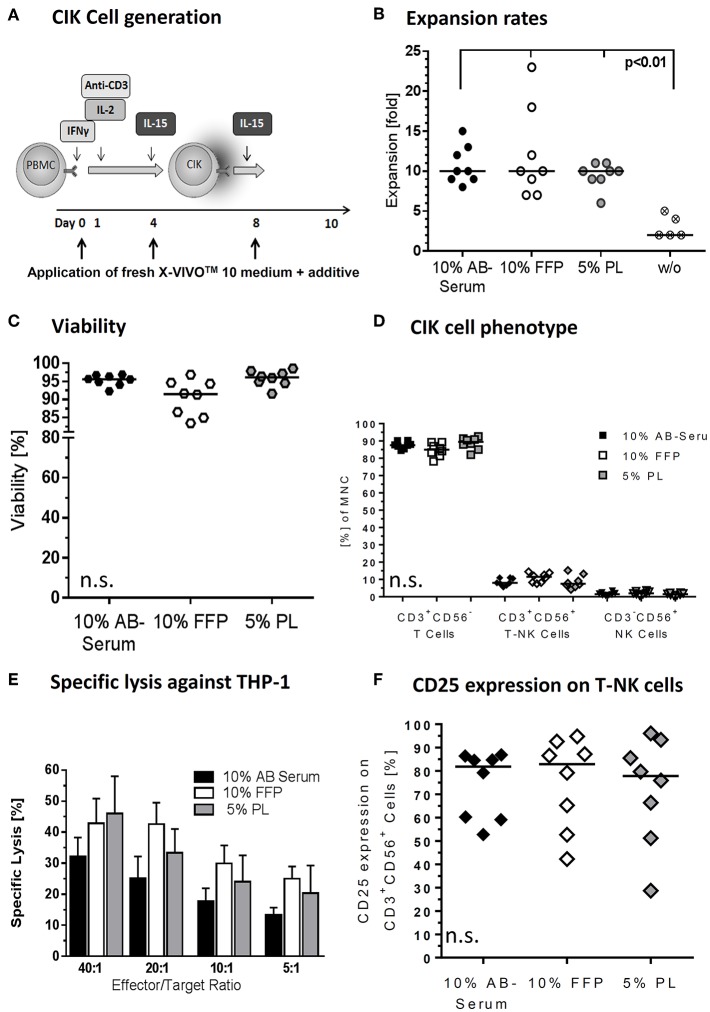
Medium supplements for CIK cell cultivation. (A) CIK cells are supplemented with fresh media including different additives on days 0, 4, and 8 of culture. We tested different additives including fresh frozen plasma (FFP) and platelet lysate (PL) in different concentrations to substitute AB serum in the cultivation process. (B) With median 10-fold expansion rates, CIK cell cultivation with 10% AB serum, 10% FFP and 5% PL was similar. CIK cell expansion without additive was significantly lower compared to cultivation with medium supplement. (C) With 91.5% viability was minimal lower when CIK cells were cultured with FFP compared to AB serum (95.6%) or PL (96.1%), but not statistically relevant. (D) The composition of CIK cells consisting of T-, T-NK-, and NK-cells was not significantly influenced by the different cultivation variants. (E) CIK cell cytotoxicity was tested against the leukemic cell line THP-1. In the effector/target ratio of 40:1 mean specific lysis was with 46.0% highest for PL-CIK cells, closely followed by FFP-CIK cells with 42.9%. In the effector/target ratios 20:1, 10:1, and 5:1, CIK cells generated with FFP as additive showed the highest cytotoxicity. (F) CD25 expression on T-NK cells was highest on CIK cells cultivated with FFP. Comparable results were obtained for CIK cells cultured with AB serum. CIK cells cultivated with PL as medium additive showed a slightly lower CD25 expression and a wider range of expression. n = 8 experiments, except cultivation without medium supplement (n = 5) and cytotoxicity analysis (n = 3).